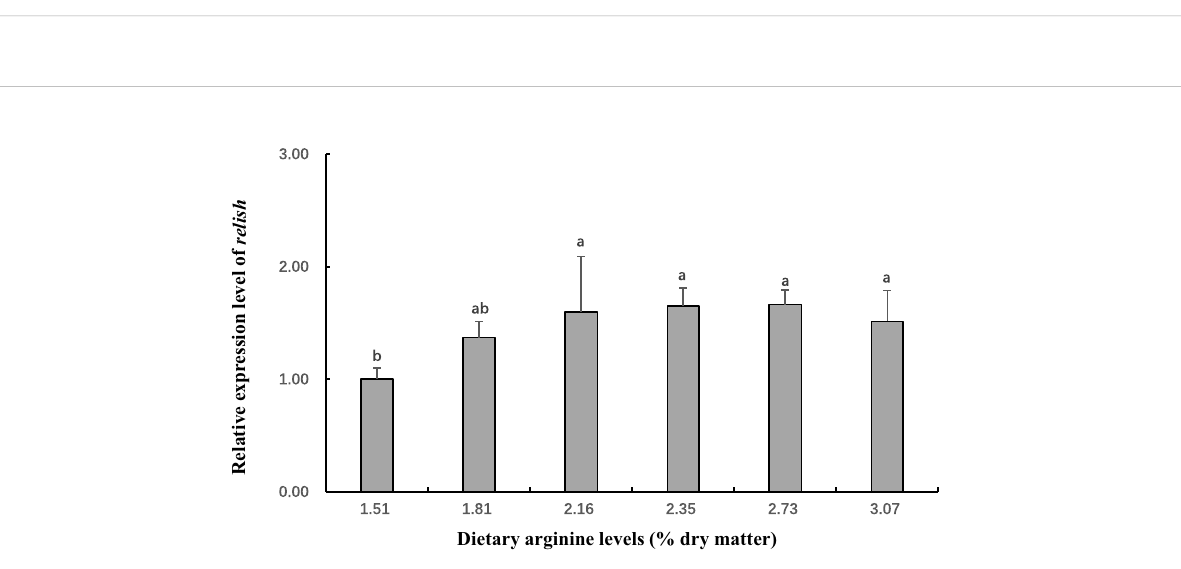
FIGURE 7 The gene expression ( relish on hepatopancreas) of postlarval Scylla paramamosain fed diet with different arginine levels. Means in the same row with different superscripts are signi fi cantly different (P<